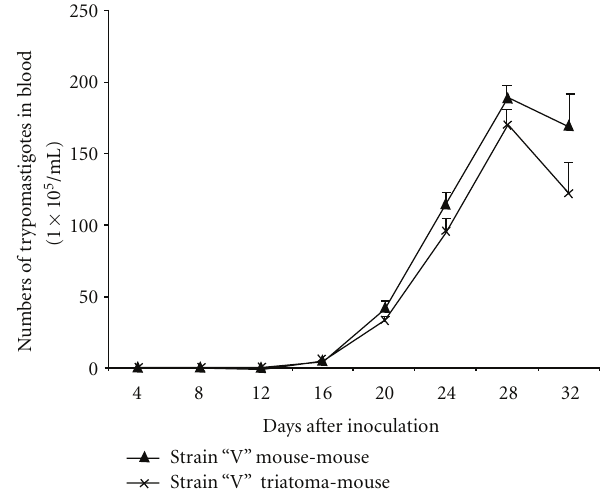
Figure 3: Parasitemia curve of strain “V” (mouse-mouse versus triatoma-mouse).